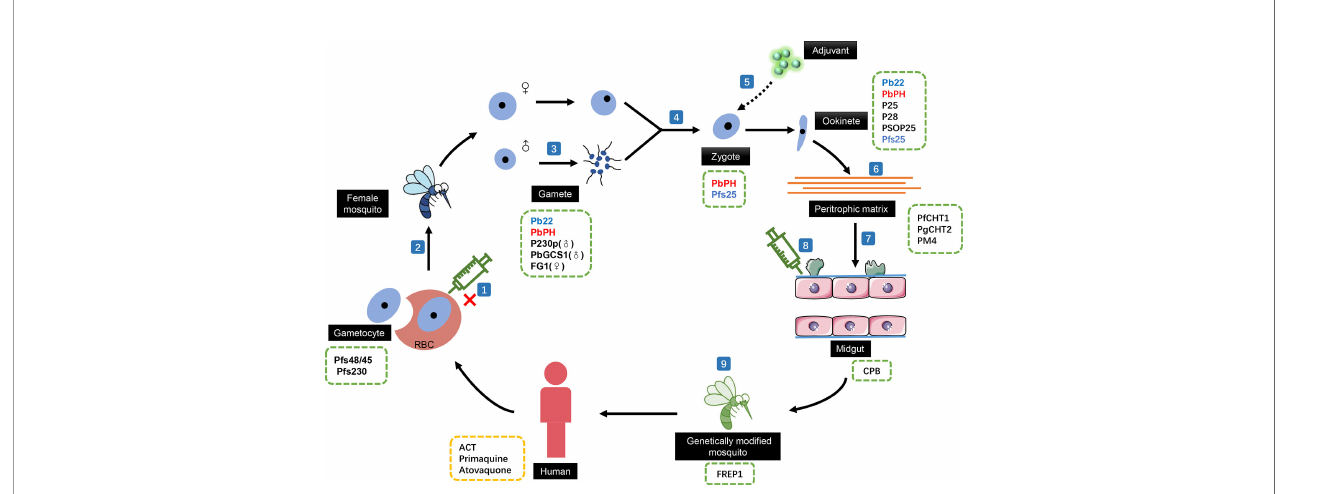
FIGURE 1 | The effect of transmission-blocking vaccines (TBVs) in the sexual reproductive stages of malaria. (1) TBV cannot act on gametocytes that have not escaped from red blood cells. The development of TBVs based on the (2) surface proteins of the gametocytes, (3) male gamete-related targets, and (4) fertilization process-related proteins can effectively block the development process of malaria in mosquito. (5) The lack of inherent antigenicity means that TBVs based on ookinete surface proteins need adjuvants in actual use. Blocking the ability of motility ookinetes to break through the (6) peritrophic matrix and the (7) physical and immune barriers of the midgut to prevent its colonization in the midgut is another development direction of TBVs. (8) TBVs targeting mosquito midgut proteins can also effectively block ookinete colonization. (9) Directly genetically modi fi ed mosquitoes to prevent the development of ookinetes. Candidate target proteins for transmission blocking antibodies in different stages of malaria life cycle were listed in green dotted boxes. Anti-malaria drugs that could in fl uence the transmission were listed in yellow dotted box. ACT, artemisinin-based combination therapy; Pfs48/45, Plasmodium falciparum gametocyte surface protein; Pfs230, P. falciparum gametocyte surface antigen; Pb22, a conserved protein (PBANKA_0305900) in Plasmodium berghei ; PbPH, P. berghei pleckstrin homology gene; PbGCS1, P. berghei Generative Cell Speci fi c 1; FG1,female gamete peptide 1; Pfs25, P. falciparum sexual-stage surface protein; P25, the major surface proteins of Plasmodium ookinetes; P28, Ookinete surface antigen-like protein; PSOP25, putative secreted ookinete protein 25; PfCHT1, P. falciparum chitinase; PgCHT2, P. gallinaceum chitinase; PM4, plasmepsin 4; CPB, Carboxypeptidase B; FREP1, Fibrinogen-related protein